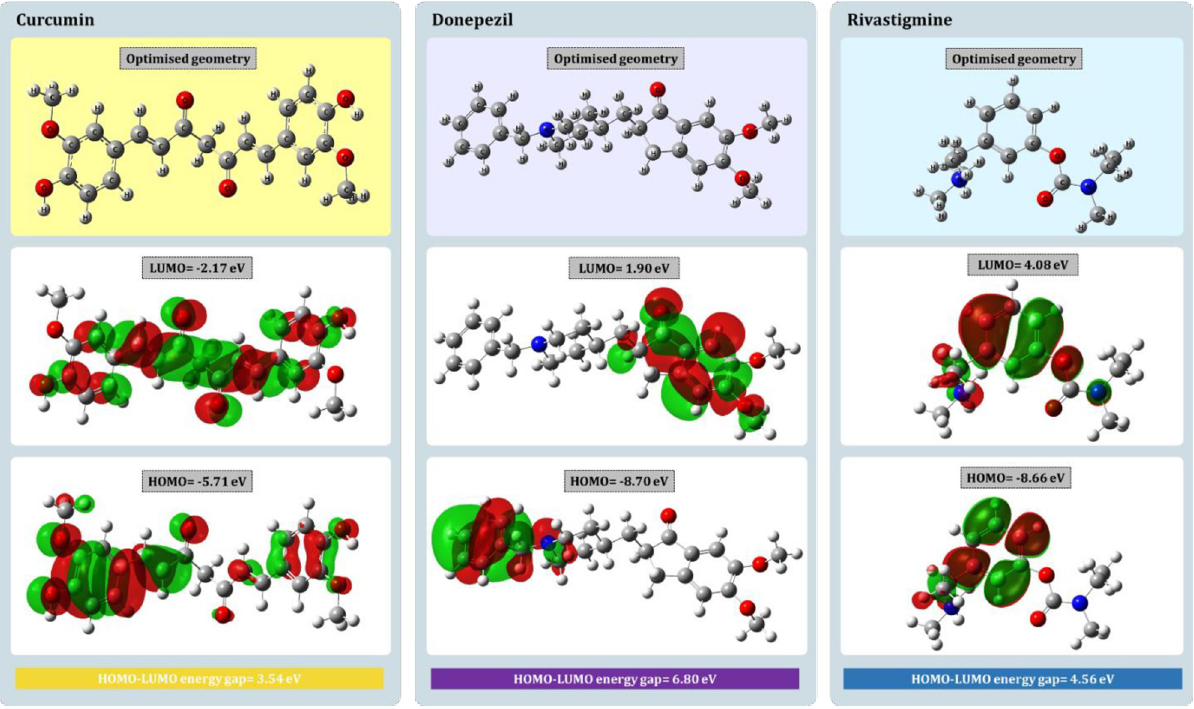
Fig 7. HOMO, LUMO and optimized geometry of curcumin, donepezil and rivastigmine obtained by DFT assessment.